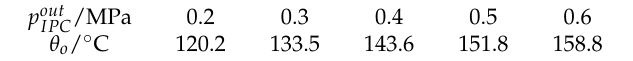
Table 1. Extraction parameters of intermediate pressure cylinder (IPC) in normal operating condition. p out IPC